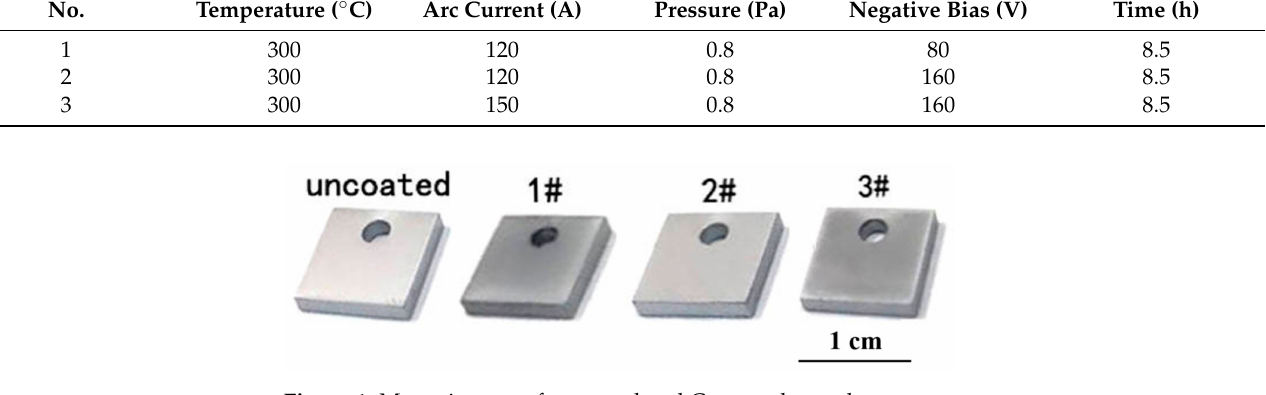
Figure 1. Macro images of uncoated and Cr-coated